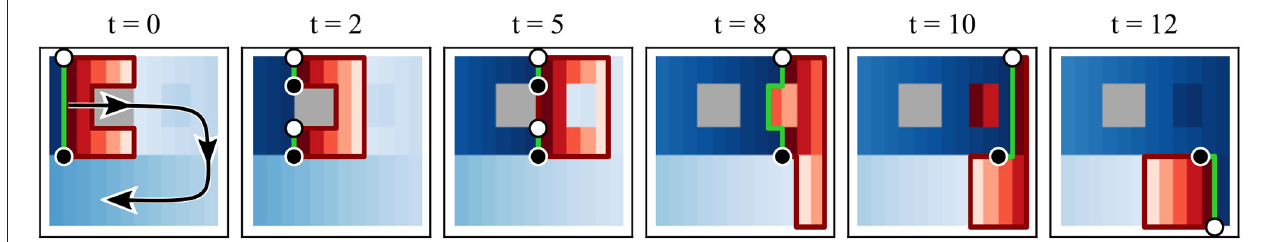
FIGURE 3 | Sketch of the PS tracking. The plot shows a clockwise rotating spiral with the green line identifying the wave front. The spiral movement is indicated by the arrow in the first panel. Red colors indicate those pixels that will be activated within the next five frames with the darkest red indicating activation within the next timestep. Blue colors show those areas that were recently activated with lighter colors indicating a longer time since the last activation. PS are identified by black or white dots. The wavefront connects a PS pair, while their possible future track is identified by a red line. In this plot τ = 5. t = 2 and 5 show the behavior at an inactive (gray) area, t = 8 and 10 at an prematurely activated area and t = 12 at the turning point.